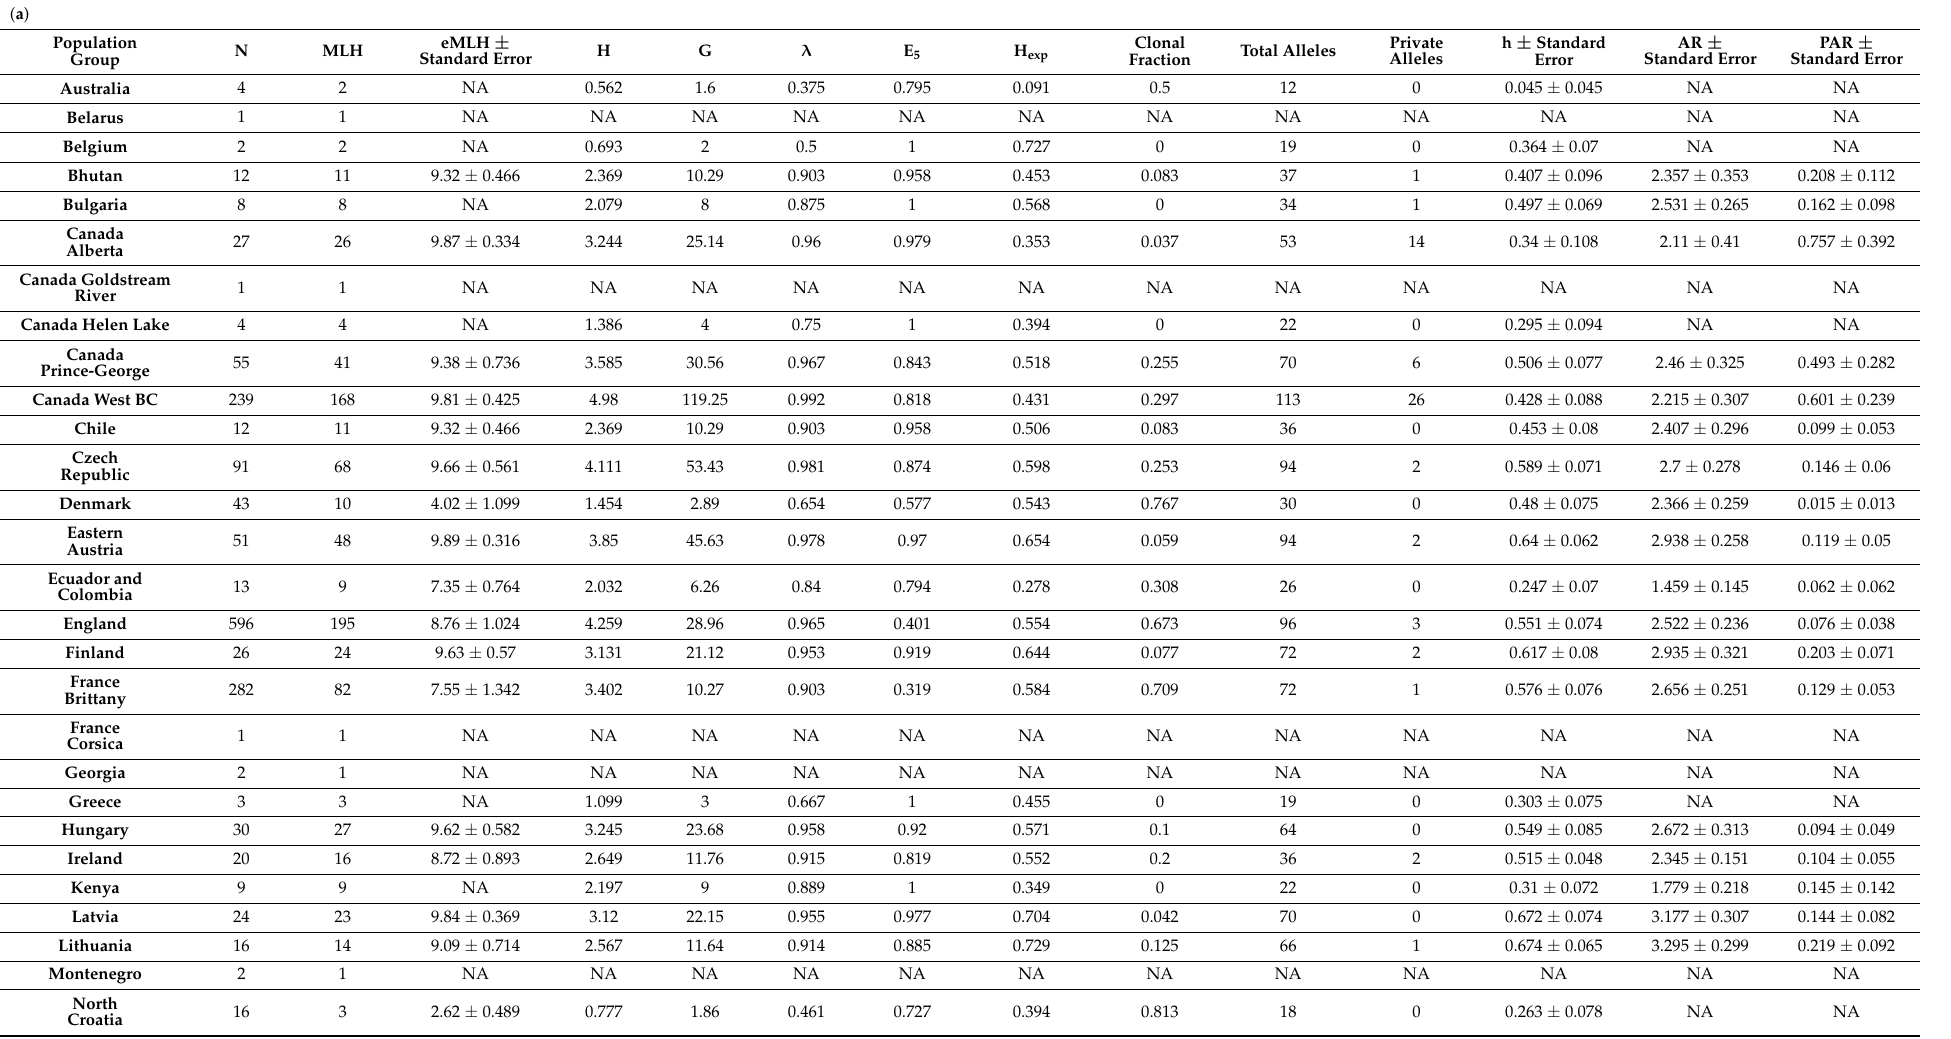
Table 1. Number of D. septosporum isolates and summary statistics for (a) the population groups; (b) the three main STRUCTURE clusters; (c) the three Eastern European